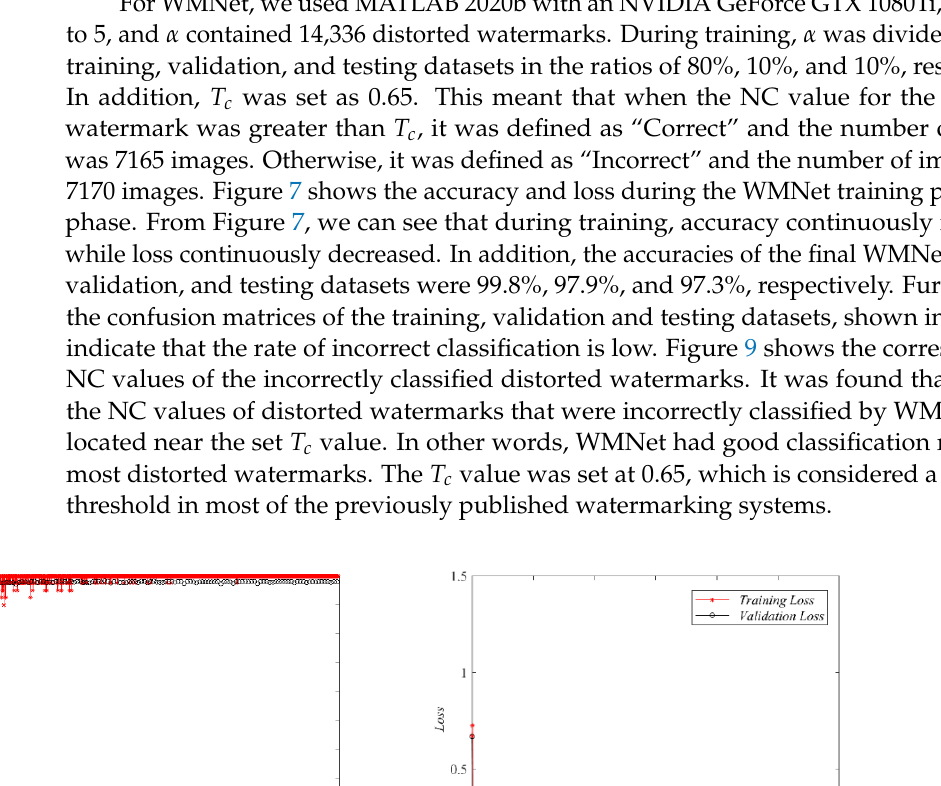
Figure 6. Simulation results when the medical image was not attacked by any image processing. ( a , b ) are the ownership share image (OSI) and master share image (MSI) ( 128 × 128 ) and ( c ) is retrieved watermarks ( 64 × 64 ) after CT image simulation; ( d , e ) are the OSI and MSI ( 128 × 128 ), and ( f ) is the retrieved watermark ( 64 × 64 ) after X-ray image simulation.